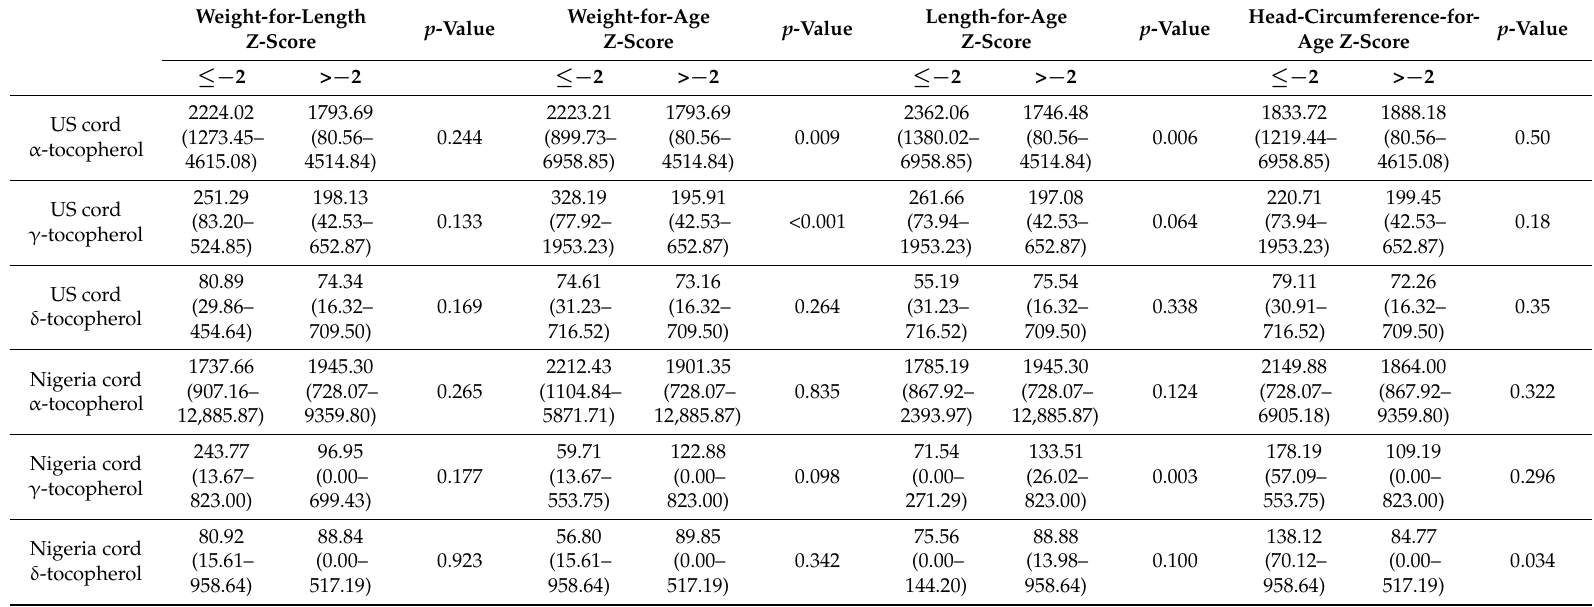
Table 5. United States infant population plasma tocopherol levels by infant growth parameter z-scores less than two standard deviations below the mean vs. two standard deviations or more below the